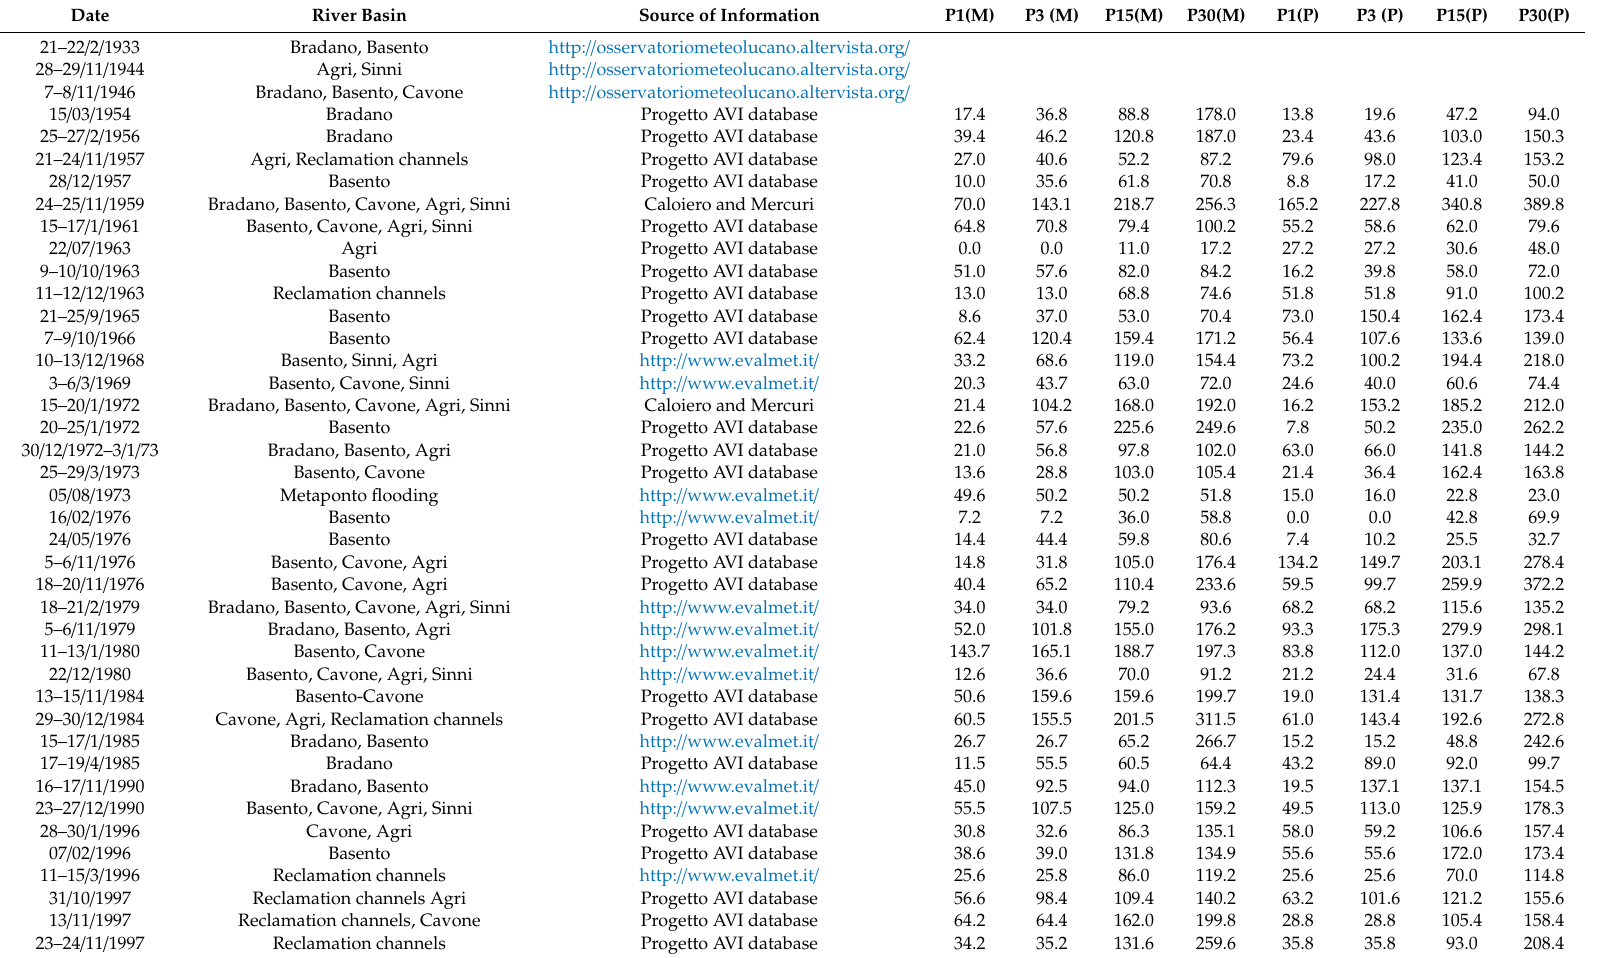
Table 1. Chronological listing of flood events in the Metaponto plain from 1933 to 2019 and antecedent rainfall conditions over three days (P3), 15 days (P15), and 30 days (P30) from the rain gauge of Metaponto (M) and Policoro